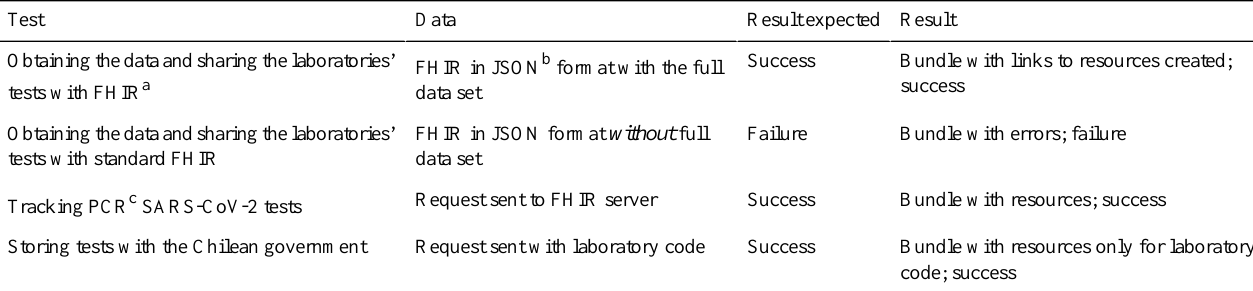
Table 3. Results from testing the functional requirements. Each functional requirement was tested.